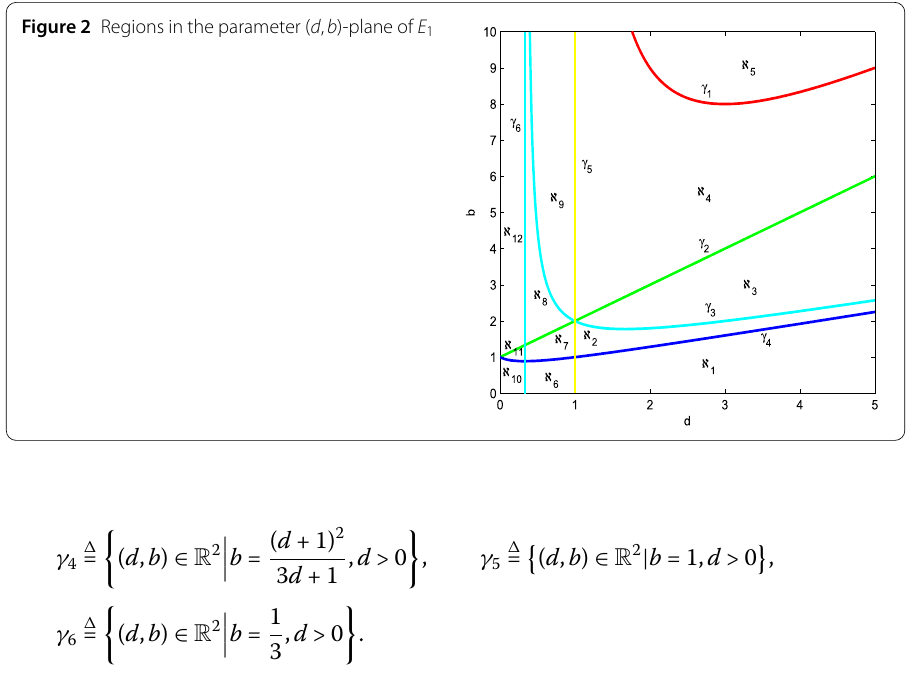
Figure 2 Regions in the parameter ( d , b )-plane of E